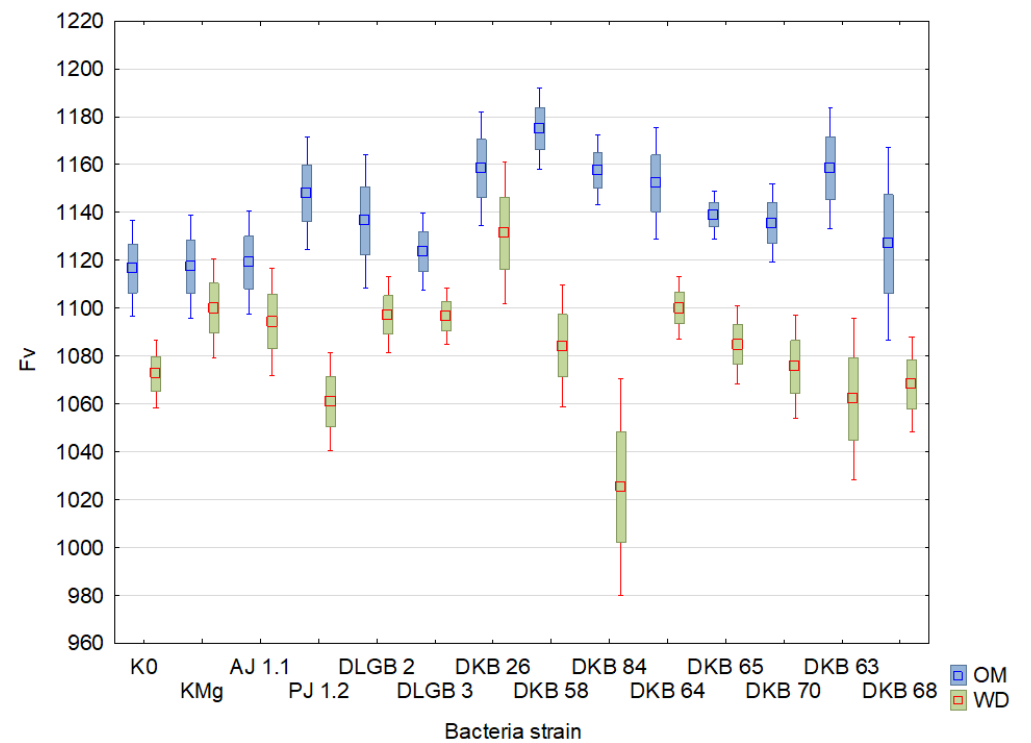
Figure 6. F V in the leaves of strawberry plants inoculated with rhizosphere bacteria growing under different substrate moisture levels, where: OM — optimal moisture, WD — water deficit.